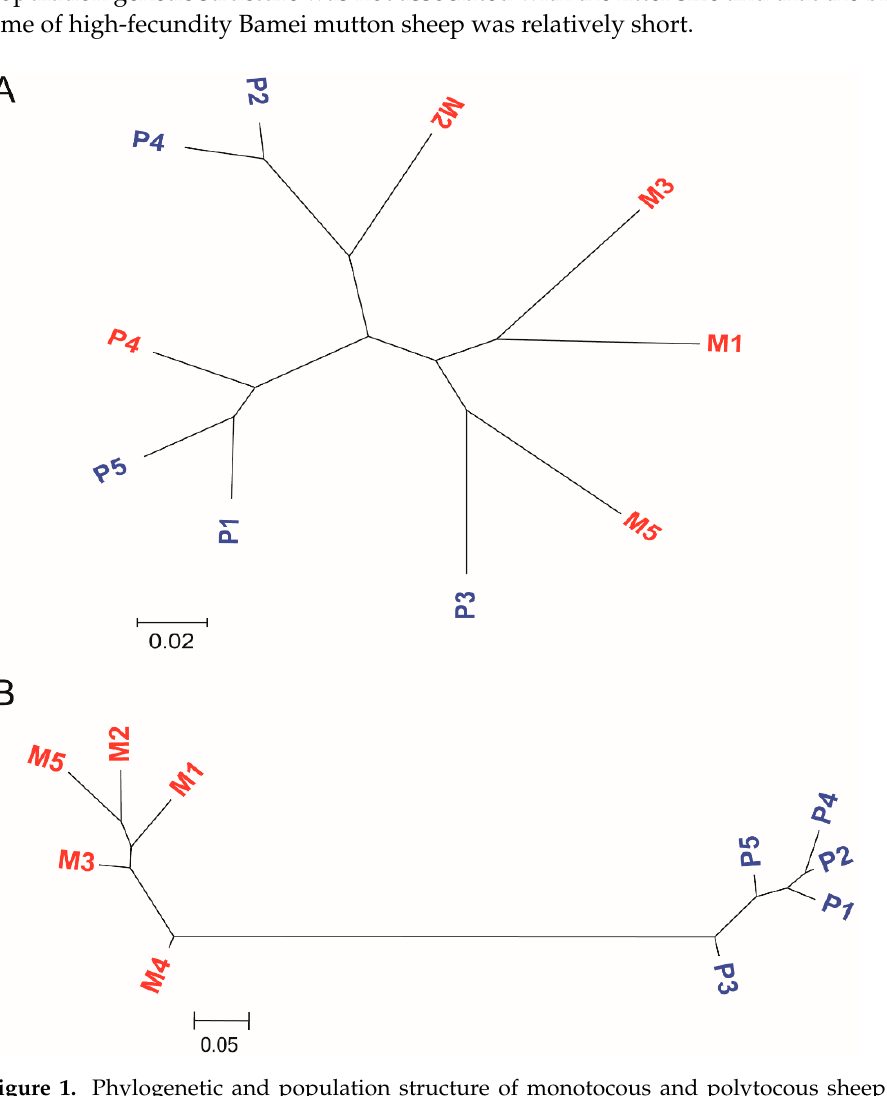
Figure 1. Phylogenetic and population structure of monotocous and polytocous sheep. ( A ) A neighbor-joining phylogenetic tree constructed using whole-genome SNP data. The scale bar repre- sents the level of similarity; Monotocous (red) and polytocous (blue) samples are indicated. ( B ) A neighbor-joining phylogenetic tree constructed using SNP data selected based on F ST